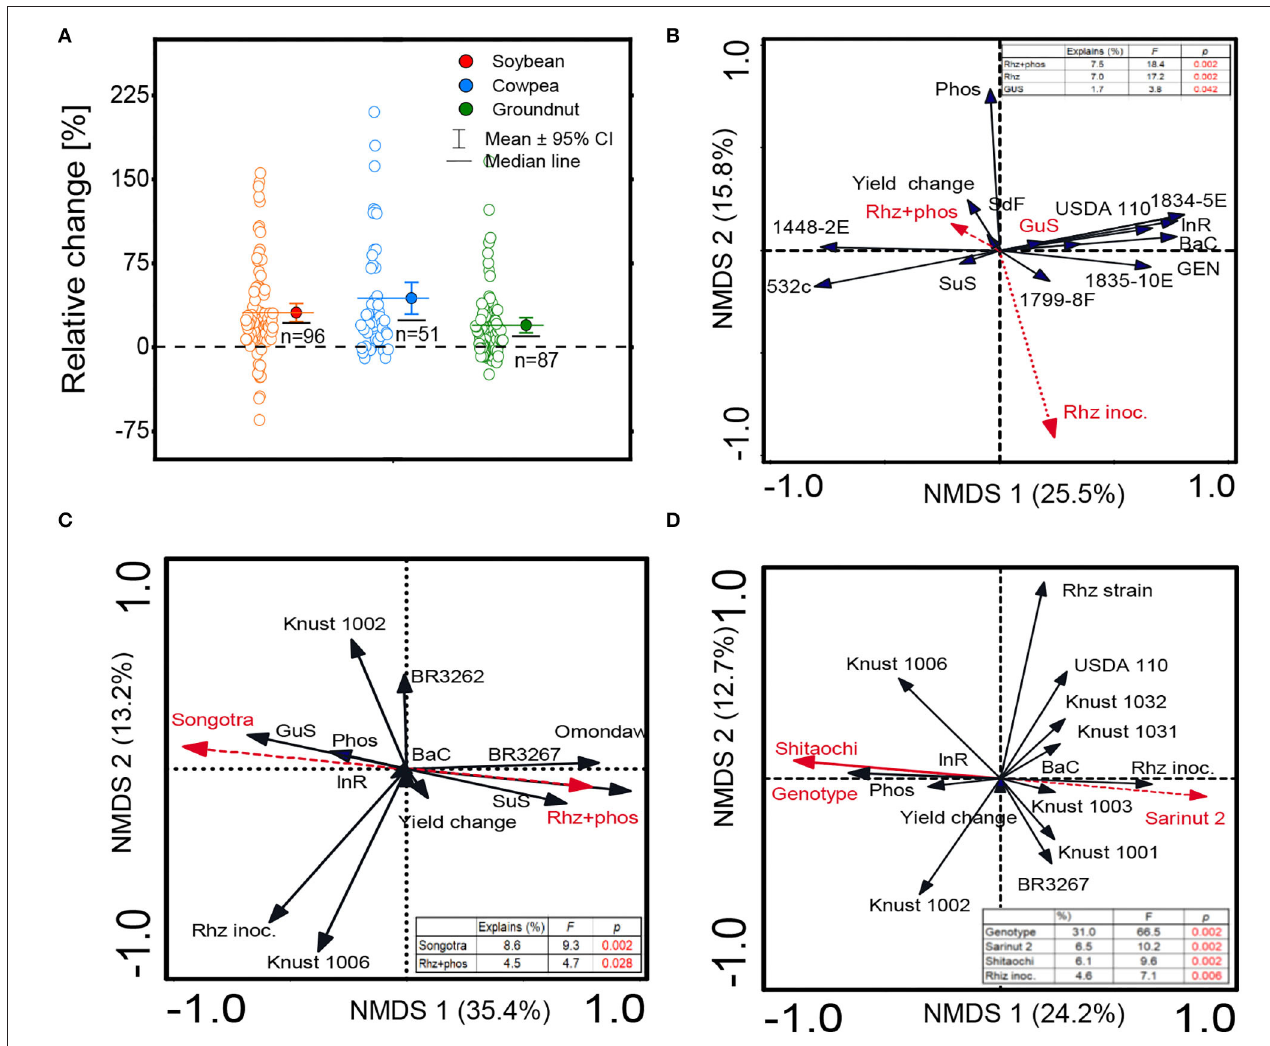
FIGURE 2 | Boxplot and scatter data (open circle symbol) of (A) the relative increase in grain yield of soybean, cowpea, and groundnut inoculated with diverse rhizobium strains compared to the uninoculated control plants under Ghanian soils and non-metric multidimensional scaling (NMDS) depicting the effect on (B) soybean, (C) cowpea, and (D) groundnut grain yield of sets of variables relative to the plant genotype, rhizobium strains, and phosphate fertilizer application. The mean values (different symbols) with a 95% bootstrap confidence interval, the median line, and the sample size are shown. Guinea savanna (GuS), Sudan savanna (SuS), Coastal savanna (CoS), semi-deciduous forest (SdF), genotype (Gen), TGx 1834-5E (1834-5E), TGx 1799-8F (1799-8F), TGx 1448-2E (1448-2E), TGx 1835-10E (1835-10E), bacterial cell concentration (BaC), inoculum rate (InR), phosphorus application (Phos), rhizobium inoculation (Rhz inoc.), and rhizobium strains (Rhz